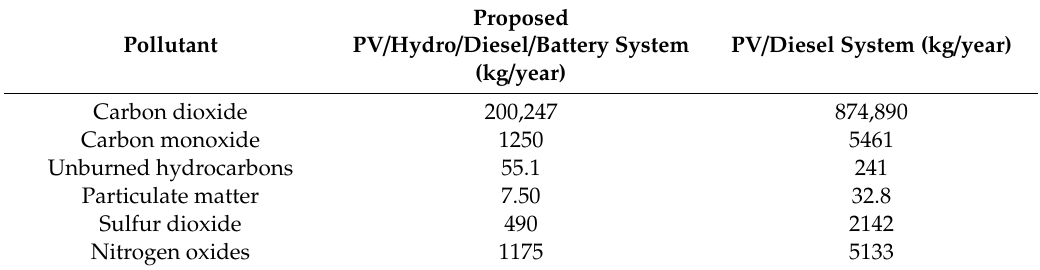
Table 3. Pollutant emissions produced by the optimal hybrid system and PV / diesel system (worst